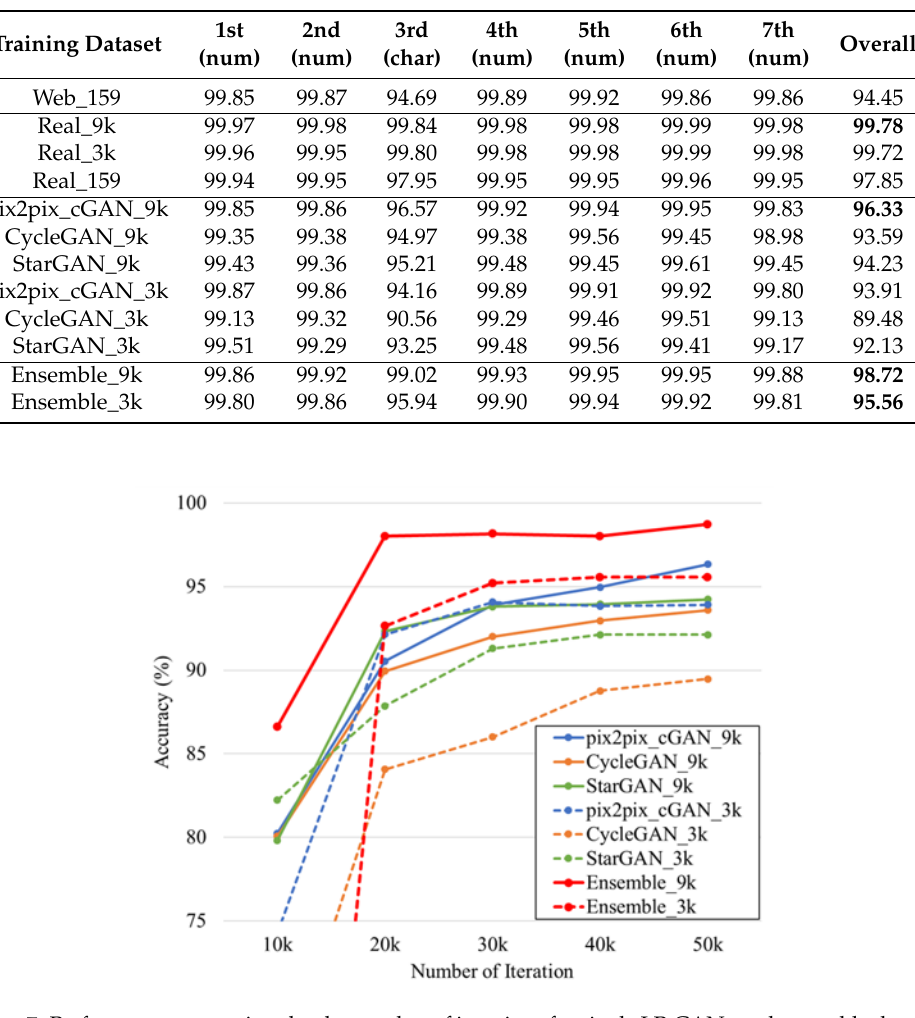
Figure 7. Performance comparison by the number of iterations for single LP-GANs and ensemble